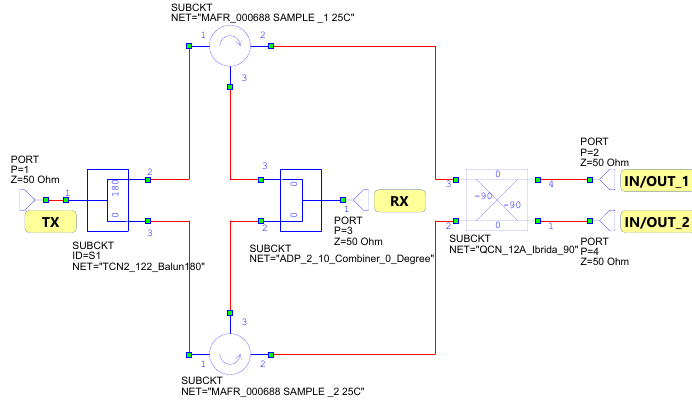
Figure 7. Microwave Office schematic of the proposed solution.